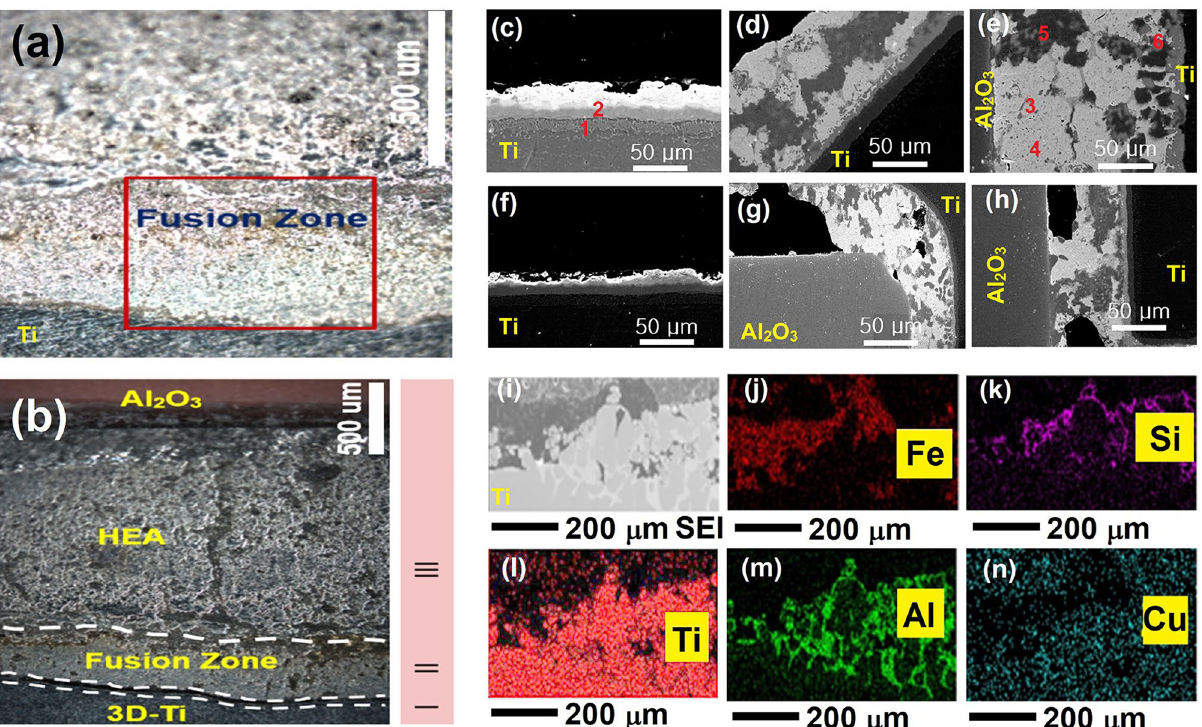
Figure 6. Brazed joint microstructure ( a ) 1050 °C, 60 s, ( b ) magnified view of ( a ). At ( c – e ) various temperatures (1010, 1050, and 1070 °C; time is fixed to 60 s) and ( f – h ) times (30, 60, and 120 s; temperature is fixed to 1050 °C). The EDS maps ( i – n ) were recorded for ( a